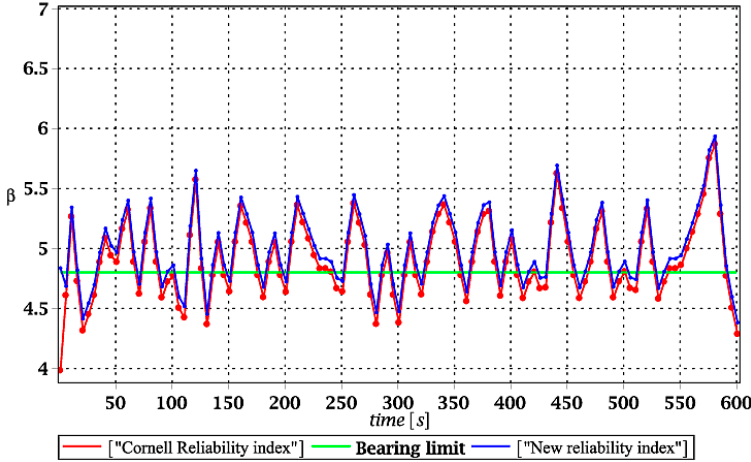
Figure 15. The comparison of dynamic reliability indices for uncertain snow load.